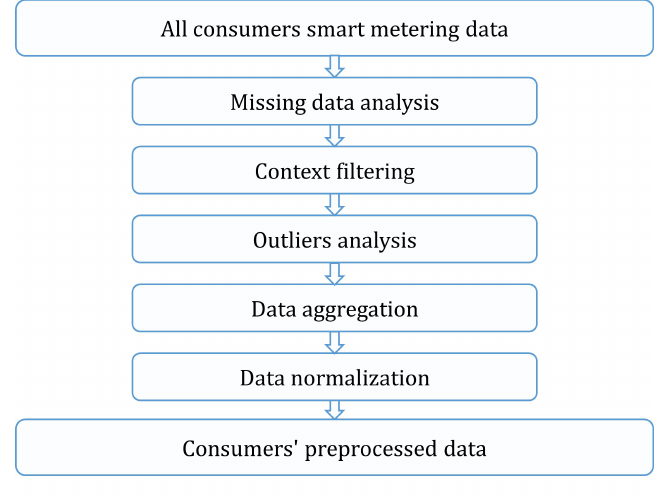
Figure 1. Outline of the data preprocessing